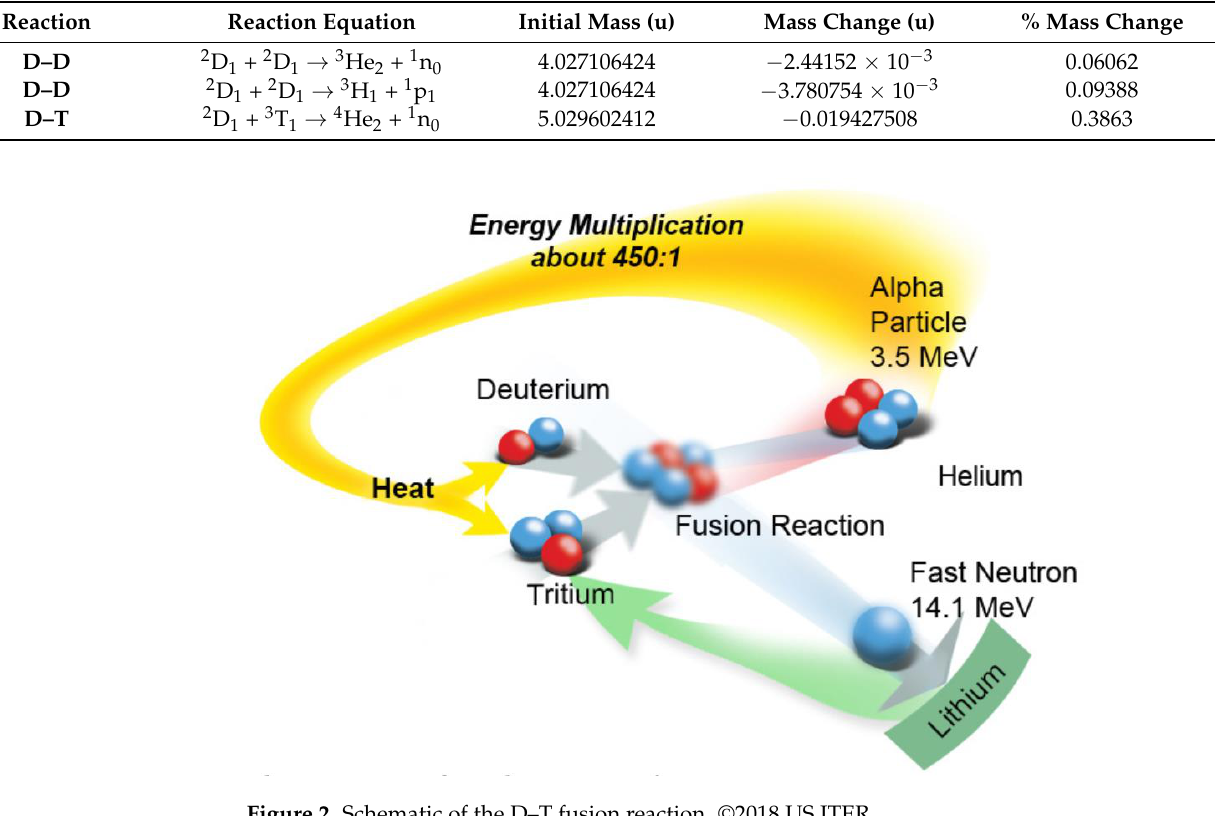
Table 2. Mass conversion factors for fusion reactions between various isotopes of hydrogen.